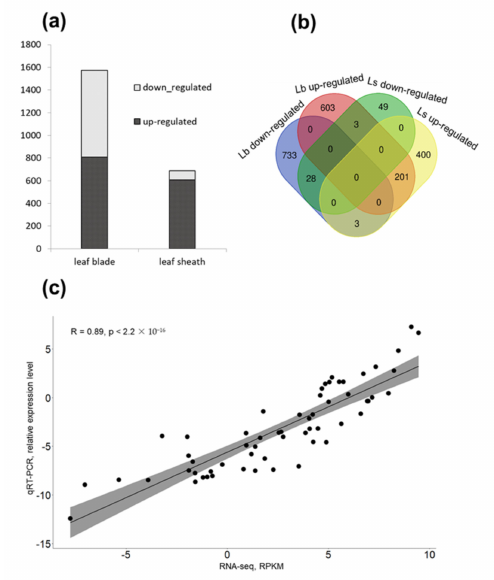
Figure 3. Analysis of differentially expressed genes (DEG). ( a ) Number of DEGs in pairwise compari- son of WT vs. win1 KO. ( b ) Venn diagram of DEGs in WT vs. win1 KO comparison. ( c ) Correlation of qRT-PCR and RNA-seq data on gene expression. lb—leaf blade, ls—leaf sheath. RPKM—reads per kilobase of transcript, per million mapped